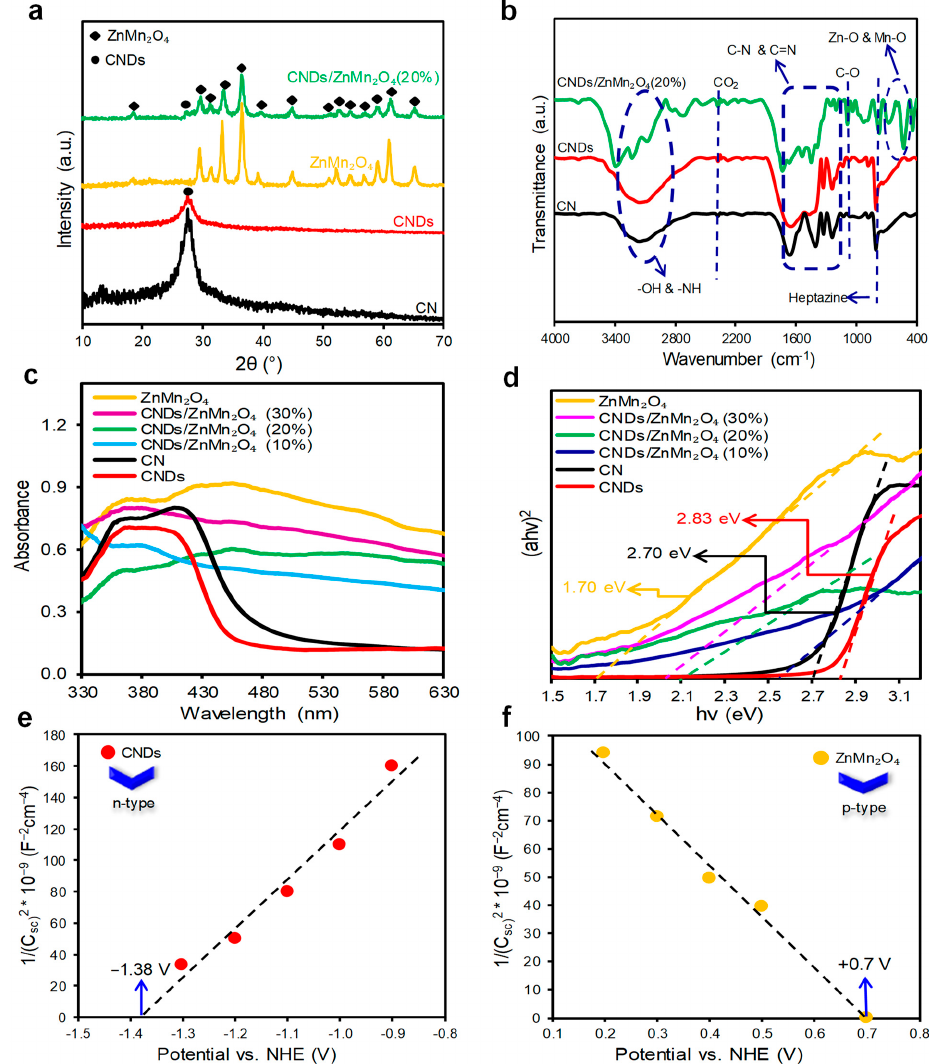
Figure 1. ( a ) XRD, ( b ) FT-IR, ( c ) Optical absorbance, ( d ) Tauc plots, and ( e , f ) Mott-Schottky plots of the specified samples .